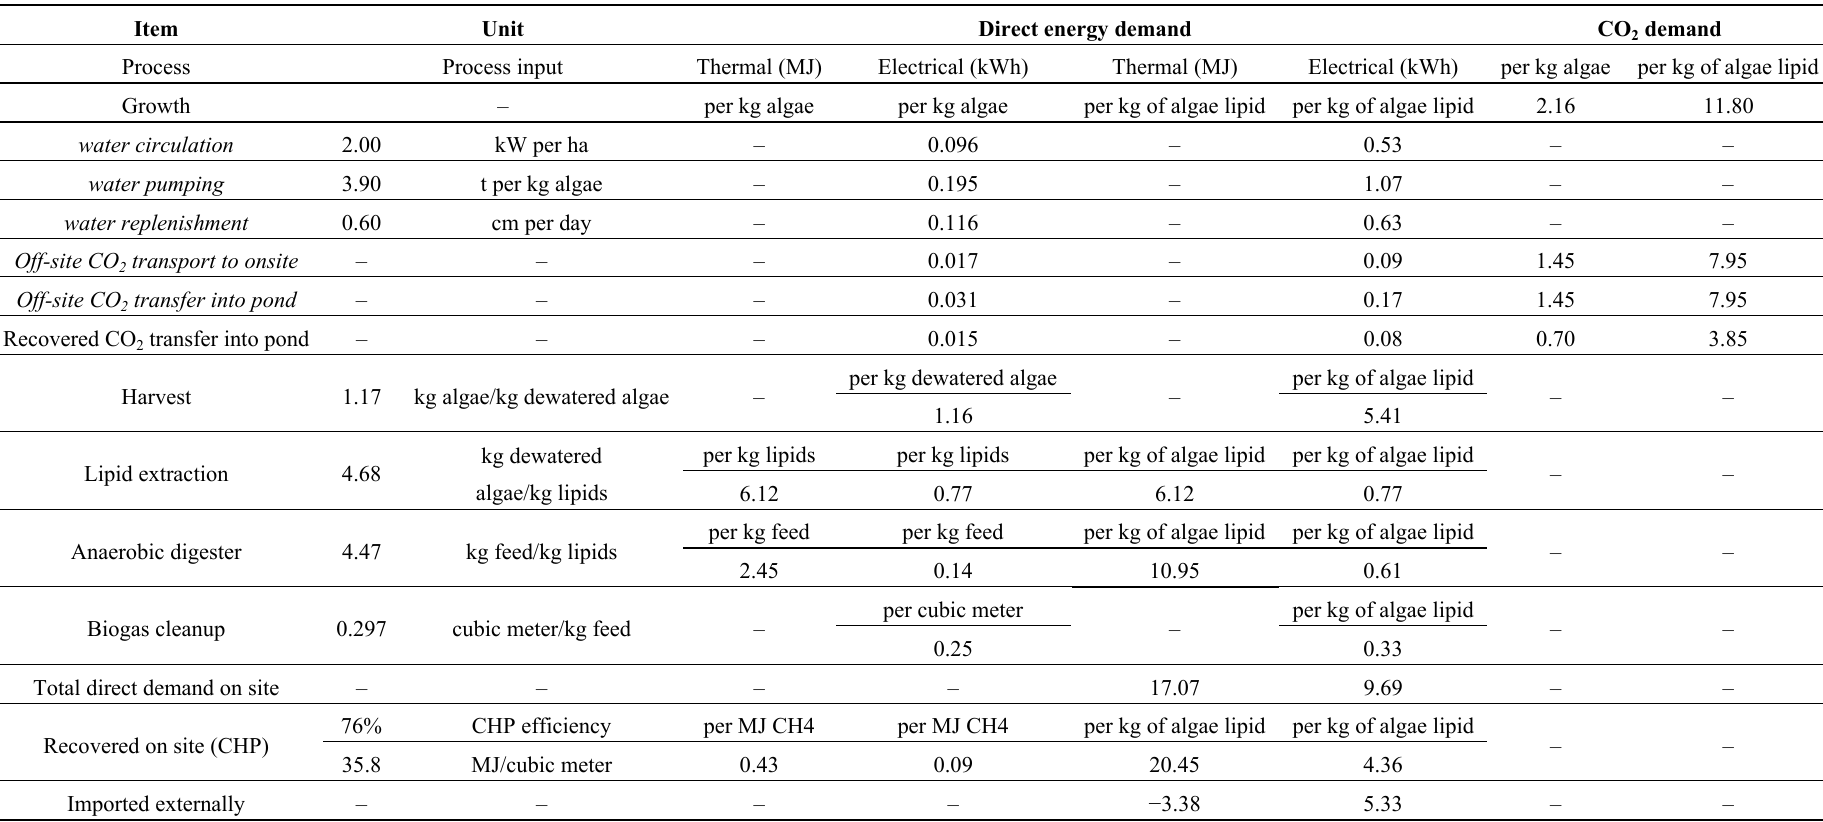
demand for process on site in basic 2